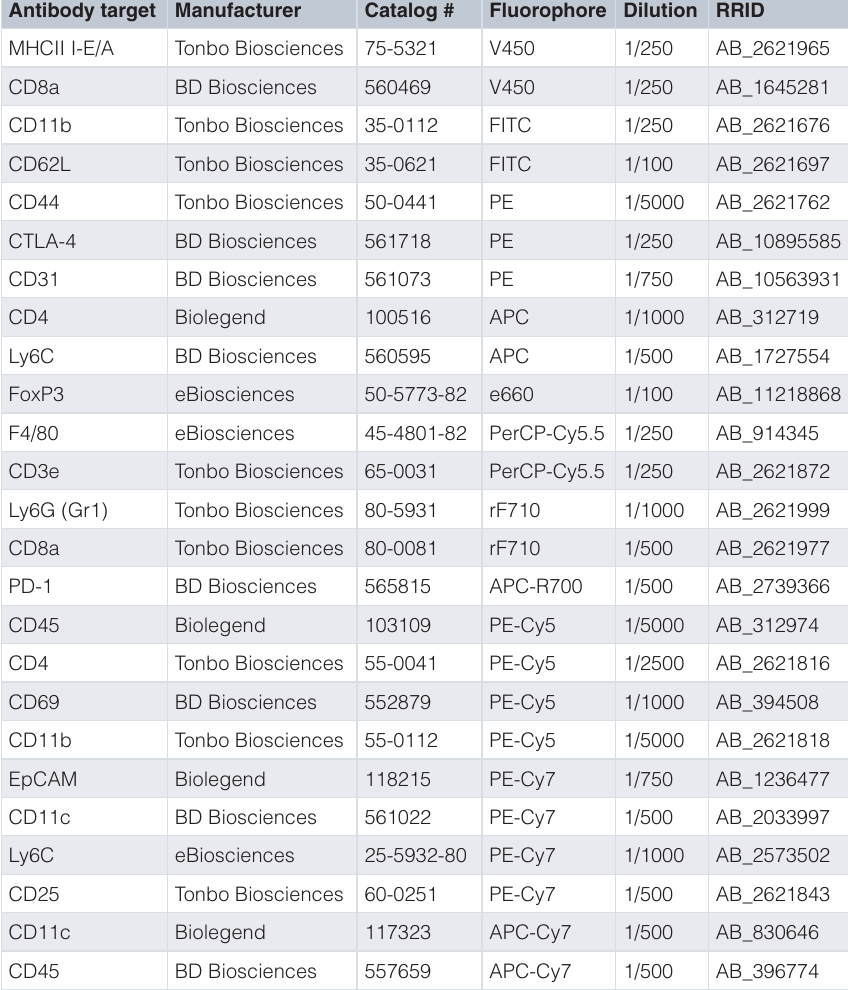
Table 1. Antibodies used in flow cytometry analysis.